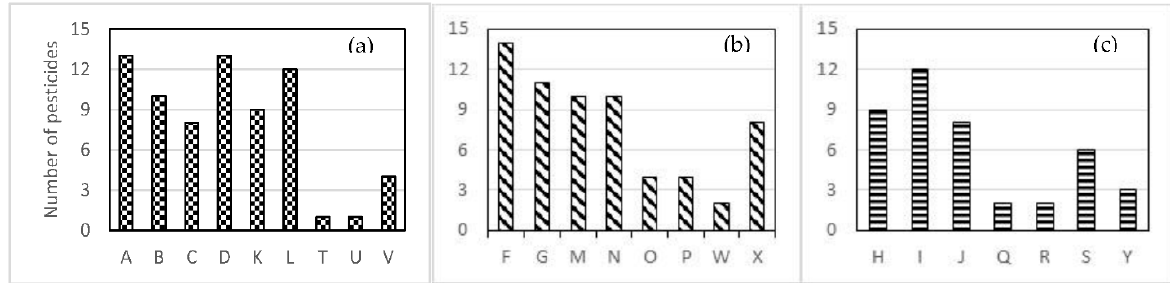
Figure 2. Cocktails of pesticide residues in dry ( a ), brine-preserved ( b ) and stuffed vine leaves ( c ) albeit at the lowest concentration levels.